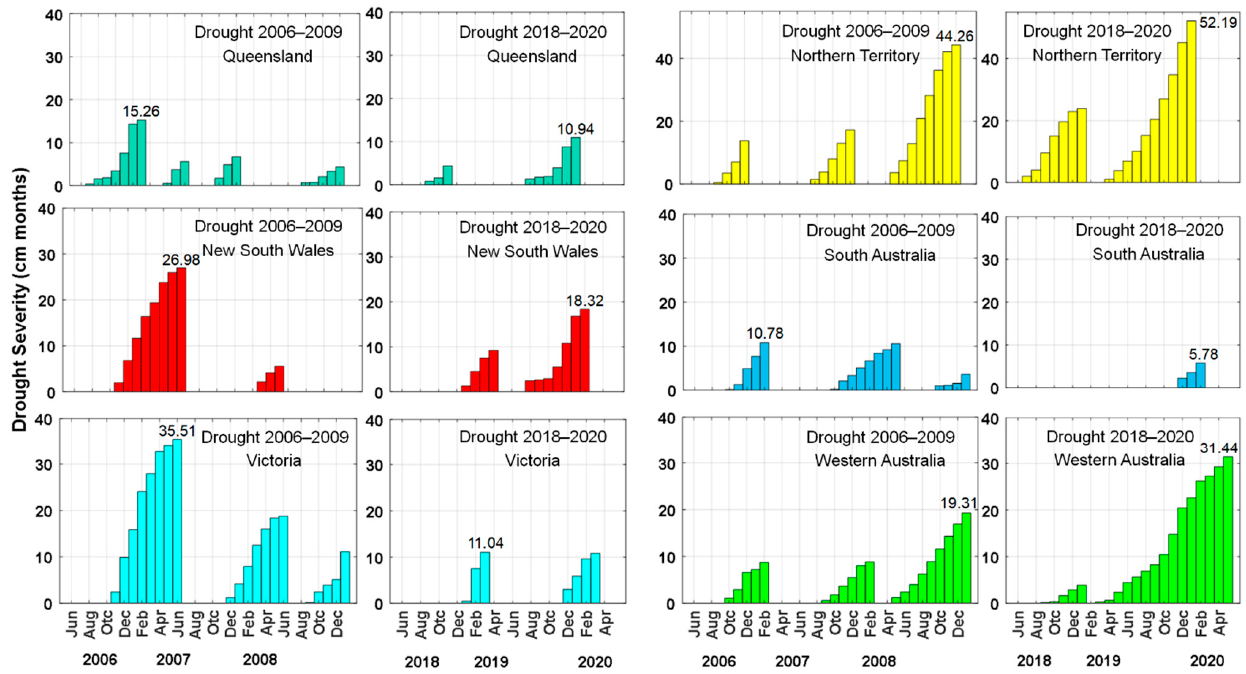
Figure 6. Drought severities among 6 regions during Drought 2006–2009 and Drought 2018–2020. 3.5. Relationships between the Two Hydrological Droughts and Indo-Pacific Climate Variability Temporal variability of Indo-Pacific climate indices with TSDI from April 2002 to May 2020 are shown in Figure 7 where the Drought 2006 – 2009 and Drought 2018 – 2020